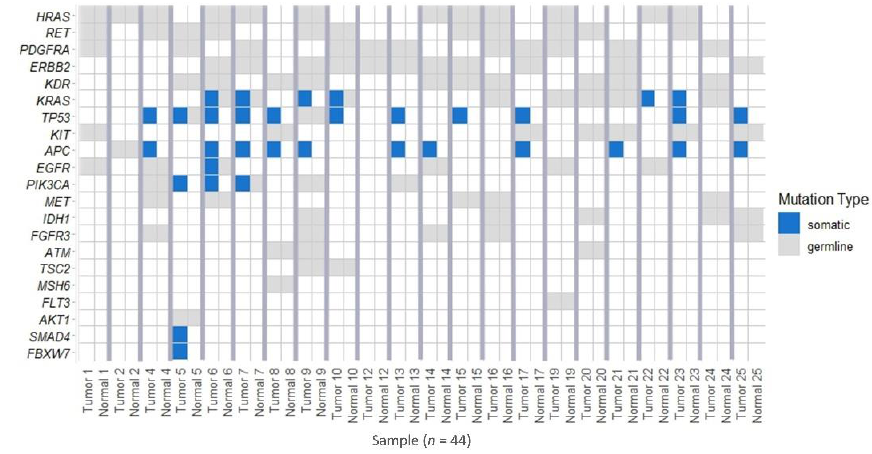
Figure 8. Waterfall plot representing the gene variants occurred in each sample. Blue squares indicate somatic variants, grey squares indicate germinal variant. Tumor and radiation-damaged mucosa tissue from the same patient are side by side.